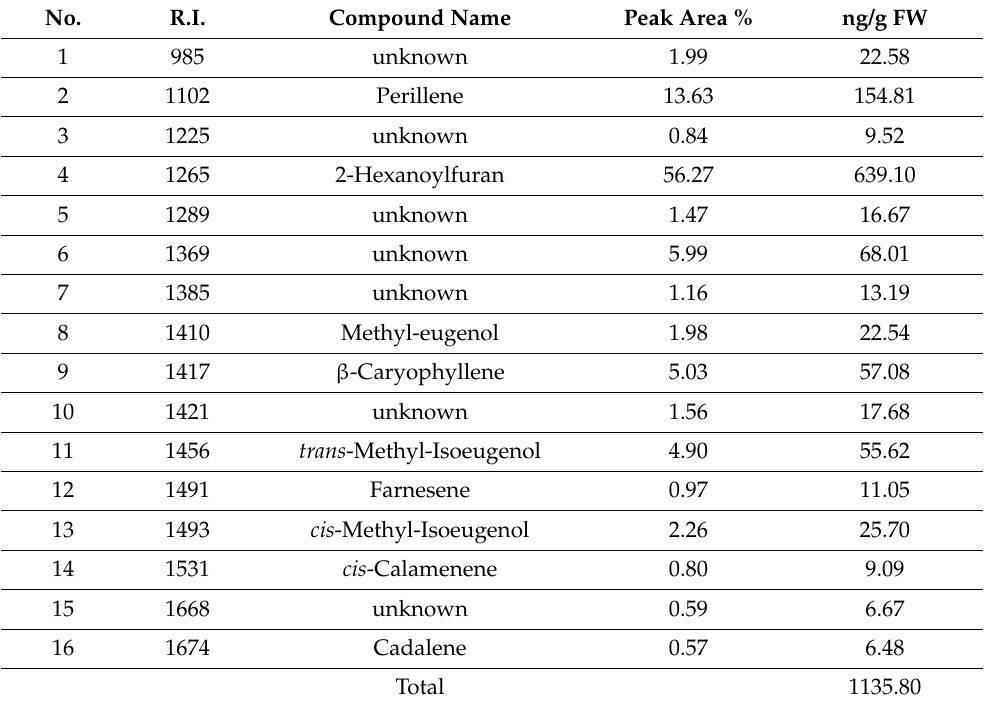
Table 4. Volatile organic compounds produced at microgreen stage by Chinese green basil (var. frutescens ) and their semi-quantitative determination (ng/g